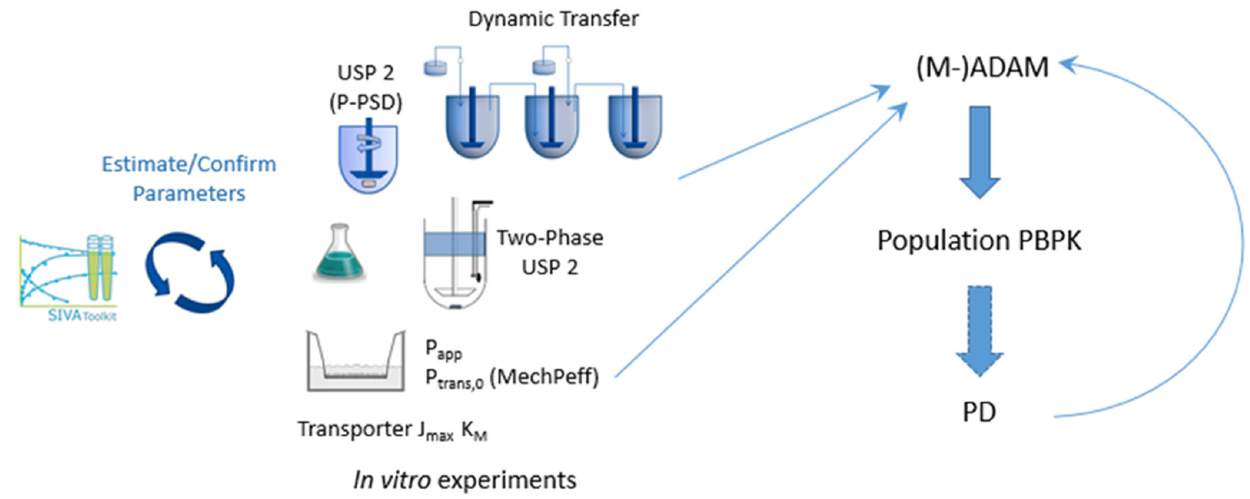
Figure 2. Coupling modelling of in vitro experiments to PBPK models. A workflow for PBPK mod ‐ elling: biopharmaceutic IVIVE.